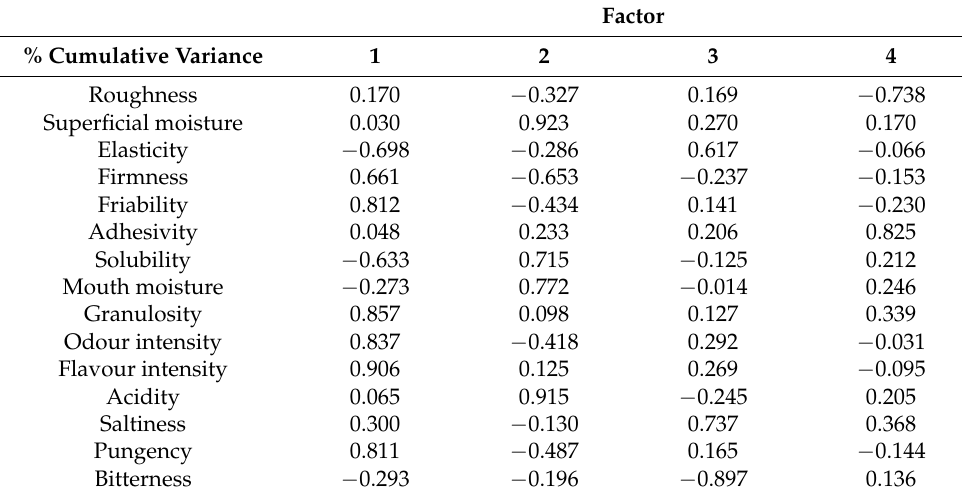
Table 7. Factor matrix obtained after a Varimax rotation.